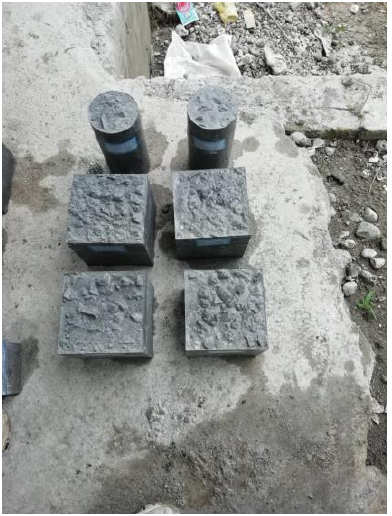
Figure 3. Construction of a control sample